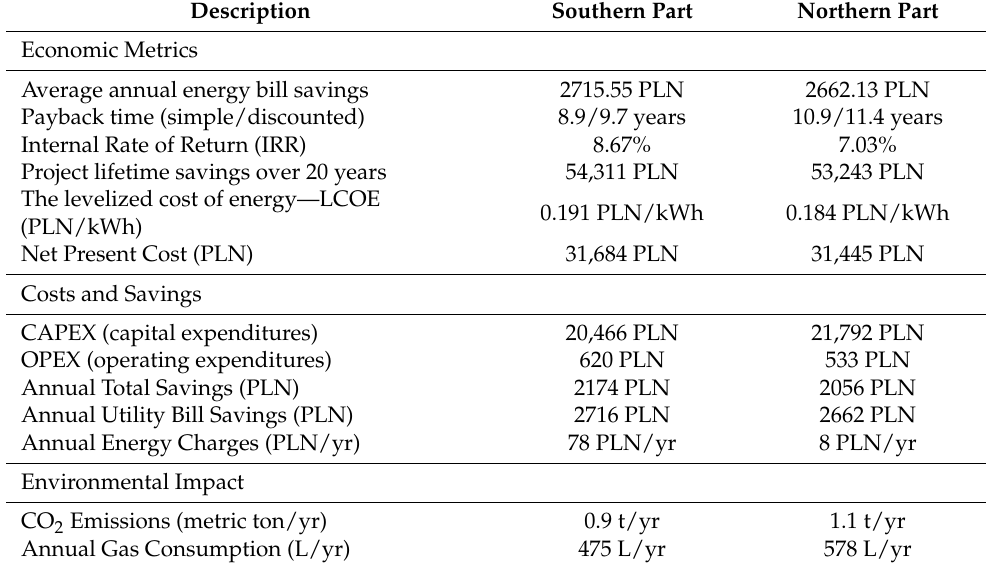
Table 3. Savings Overview: Wind + Generator + Storage: 1kWh LI +